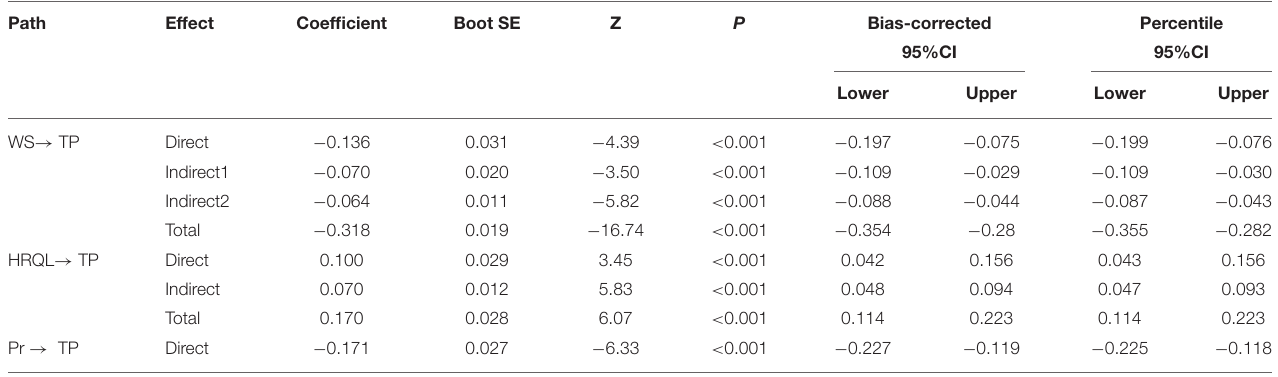
TABLE 3 | Results of the effects on task performance.